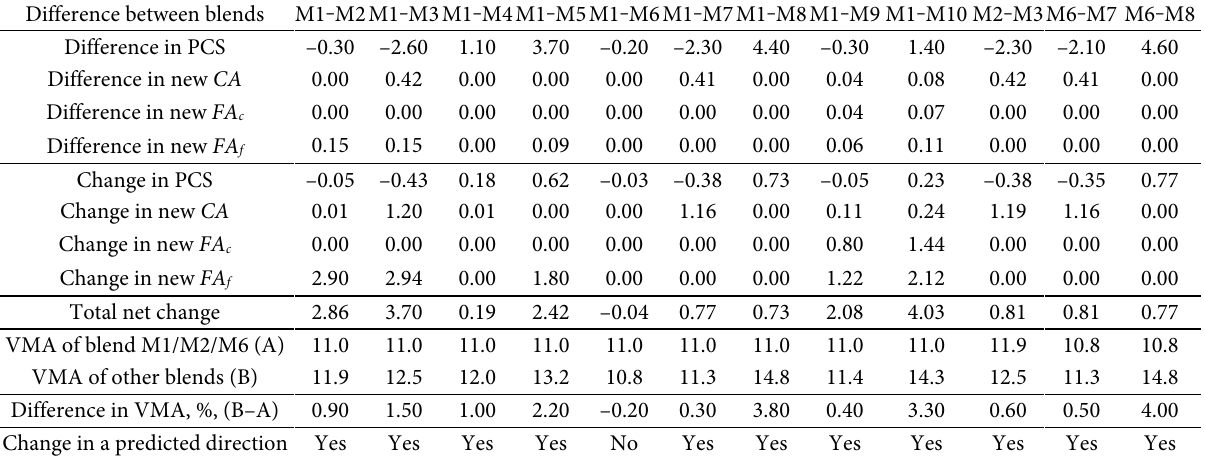
VMA of blend M1/M2/M6 (A) VMA of other blends